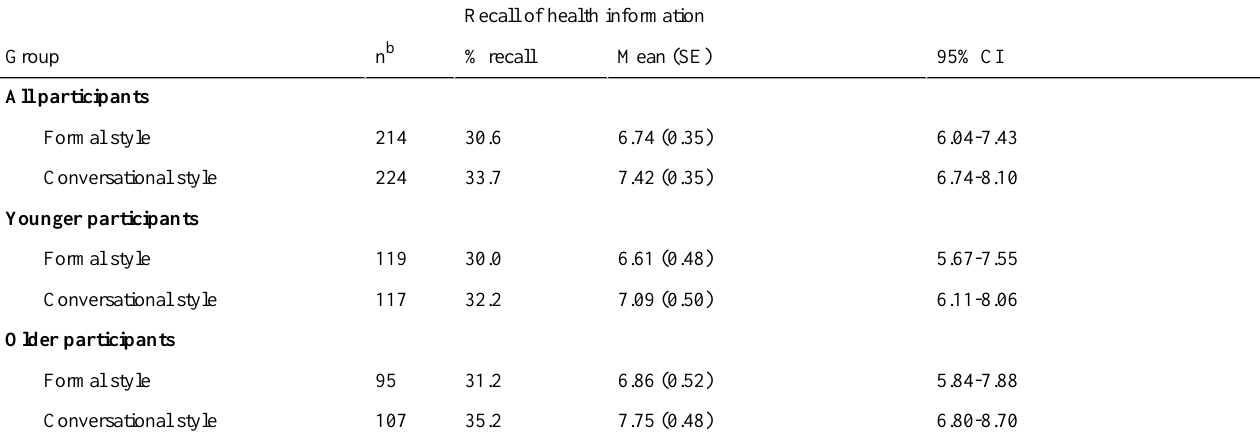
Table 3. Main effects of narration style on recall of eHealth information in younger and older adults.